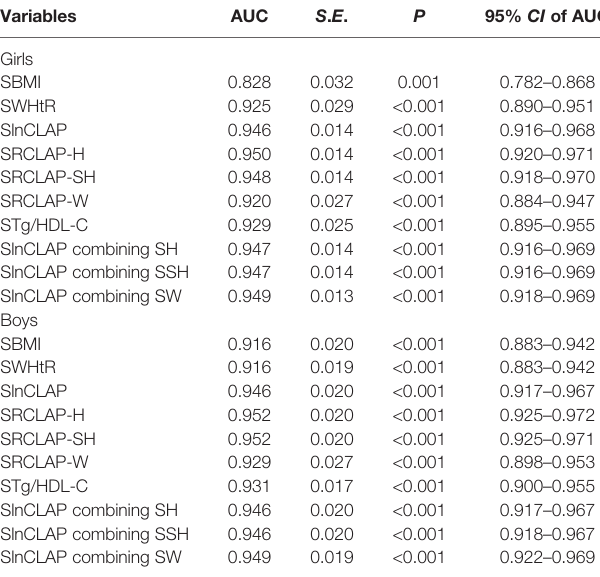
TABLE 3 | The adjusted associations between WHtR, BMI, Tg/HDL-C, CLAP, and RCLAP on MS using logistic regression models. Variables